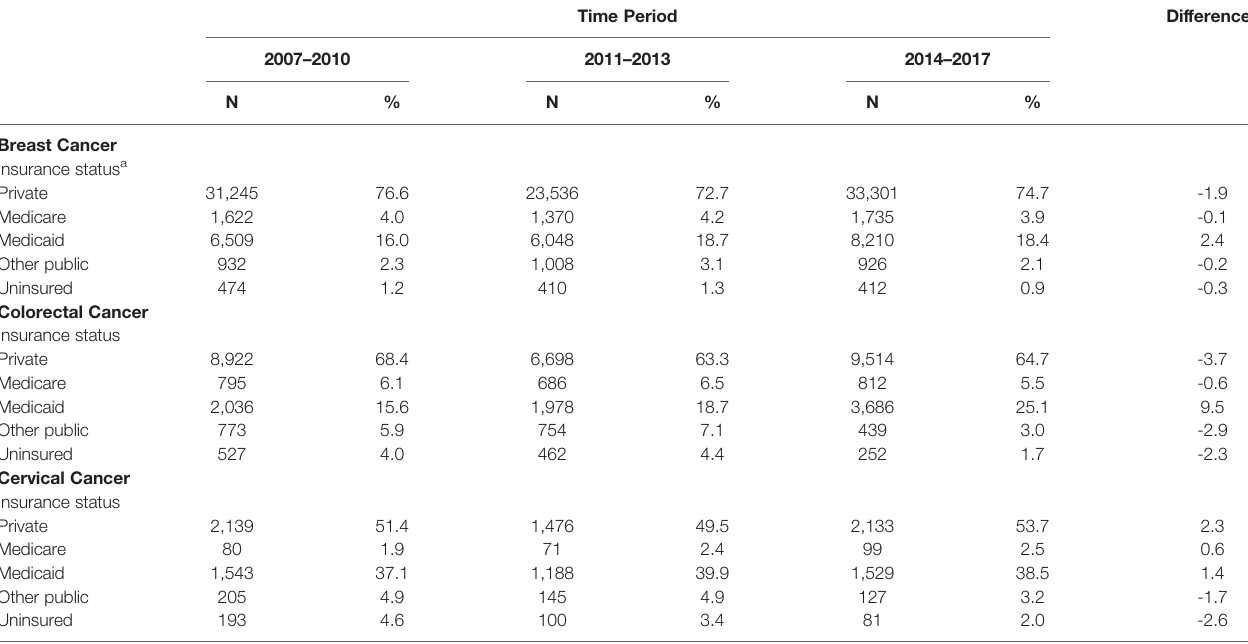
TABLE 2 | Insurance Status by Time Period for Breast, Colorectal, and Cervical Cancer Patients Under 65 Years of Age, California, 2007 –